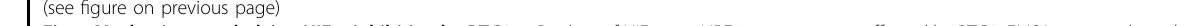
Fig. 4 Mechanisms underlying HIF-1 inhibition by BTG3. a Binding of HIF-1 α to HRE in vitro was not affected by BTG3. EMSA was conducted with nuclear extracts prepared from untreated cells or cells treated with CoCl 2 and 32 P-labeled oligonucleotide carrying HRE from the VEGFA promoter. Right panel, positive control showing that binding of E2F1 to the response element in the ARF promoter (EREA) is inhibited by recombinant full- length (FL) BTG3 and the N-terminal domain but not the C-terminal domain. Arrows indicate the speci fi c protein – DNA complexes which could be competed away by speci fi c antibodies. b Same as in ( a ) but with the HRE from the COX2 promoter. c Binding of HIF-1 α to the VEGFA and COX2 promoters was enhanced in BTG3-downregulated cells. Chromatin immunoprecipitation (ChIP) was performed with control or BTG3 knockdown IMR- 90 cells using anti-HIF-1 α antibody. VEGFI and VEGFII represent two sequences in the VEGFA promoter that conform to HRE. Mean ± SD from 3 independent experiments is shown. *, P < 0.05. d Coexpressed BTG3 disrupted the interaction between HIF-1 α and p300. 293T cells were transfected with HA-p300 and HA-HIF-1 α with or without cotransfection with myc-BTG3. Co-immunoprecipitation was performed using anti-p300. e p300- dependent HIF-1 α acetylation was reduced by co-expression of BTG3. Experiment was conducted as in ( d ) except that anti-HIF-1 α antibody was used for immunoprecipitation.